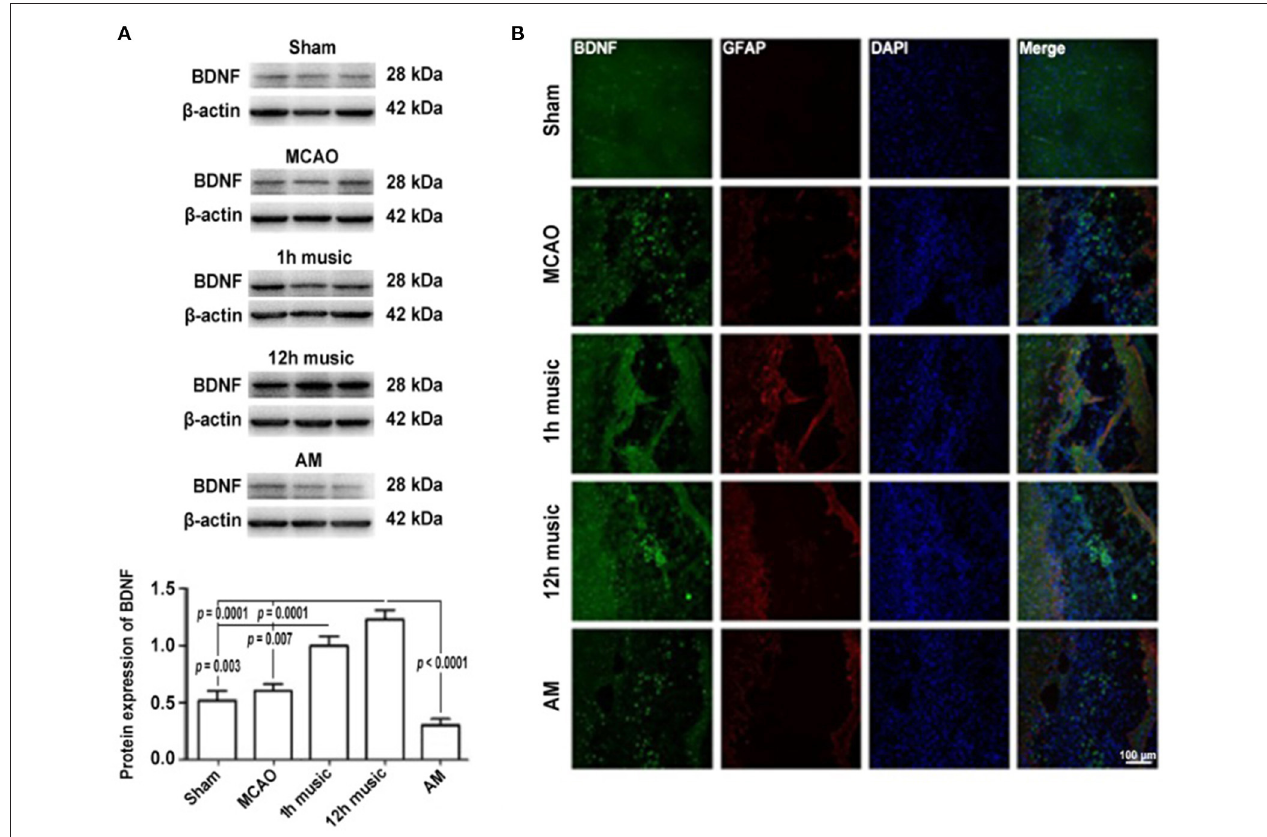
FIGURE 4 | Music therapy after MCAO increased the BDNF expression. (A) Western blot analysis of BDNF in the lesioned area. (B) Relative fluorescence intensity of BDNF and GFAP in the motor cortex. Music therapy was started on the eighth day after MCAO, and the treatment continued for 2 weeks.